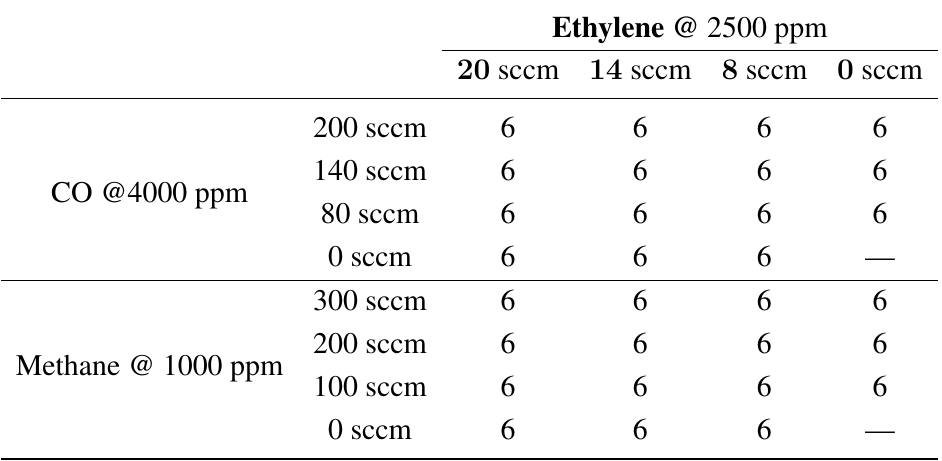
Table 2. Number of samples acquired during the generation of the